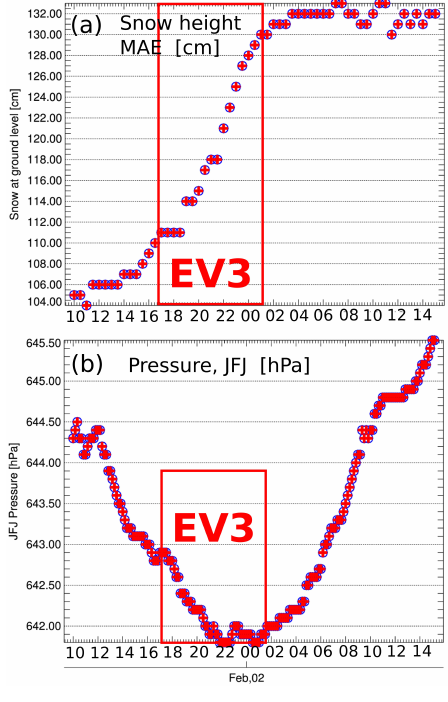
Figure 11. Evolution of (a) snow accumulation at ground level (cm), measured at the MAE site, and (b) in situ environmental pres- sure (hPa) measured at the JFJ location during